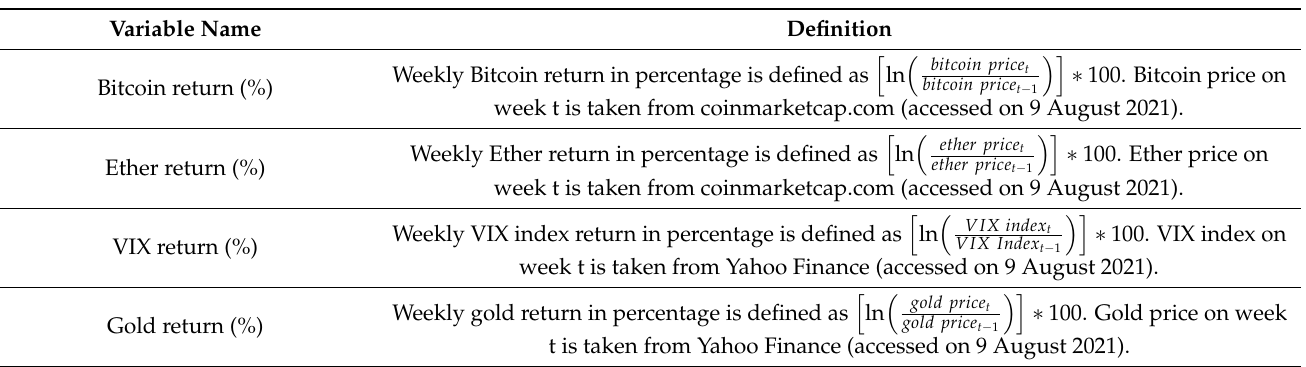
Table A1. Definitions of